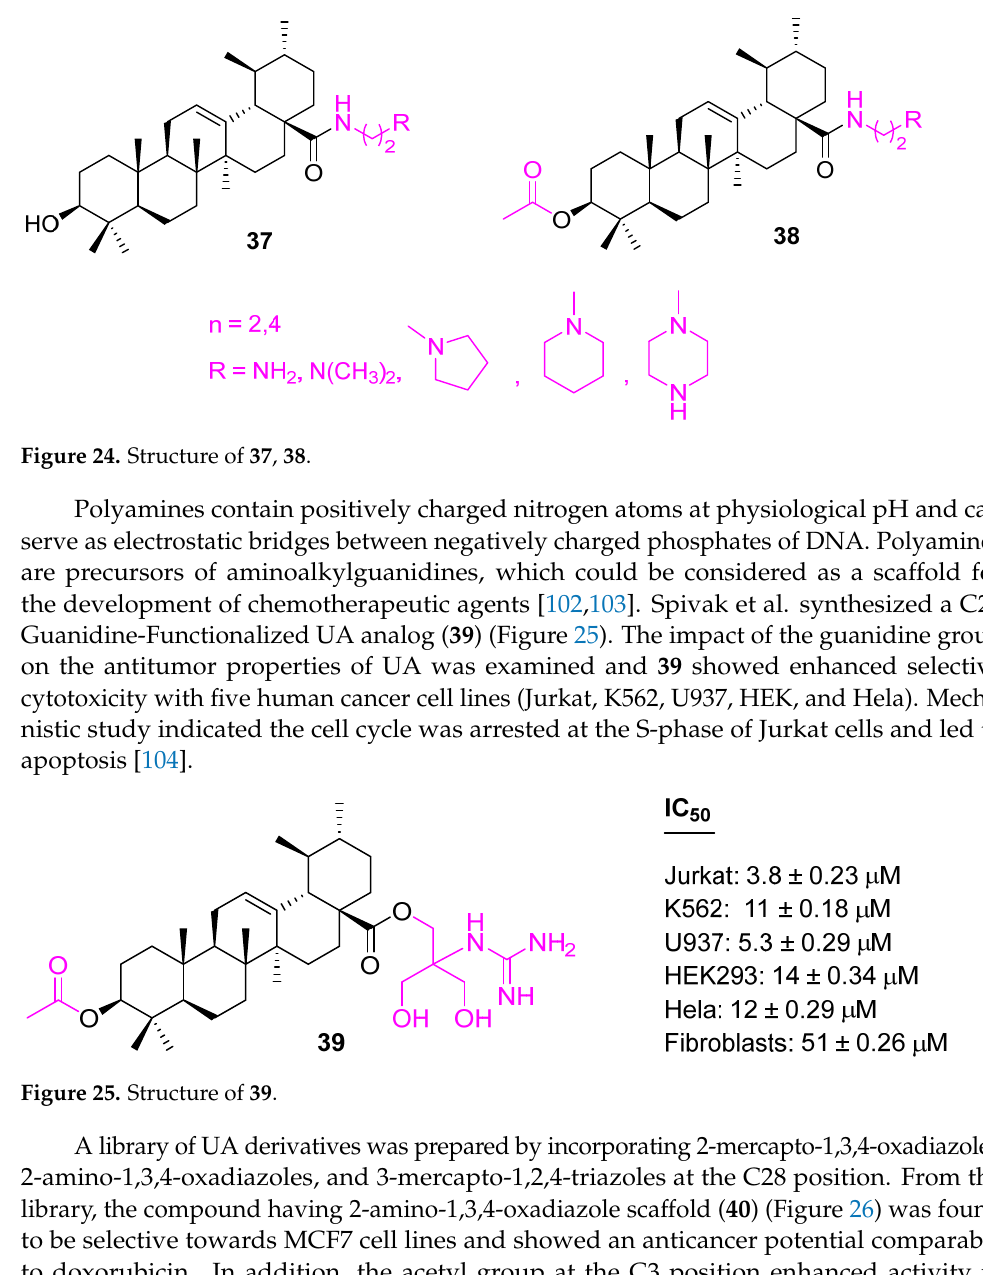
15 of 29 Figure 23. Structure of 36 . A set of ethylenediamine-spacer carboxamides of UA ( 37 and 38 ) (Figure 24) were